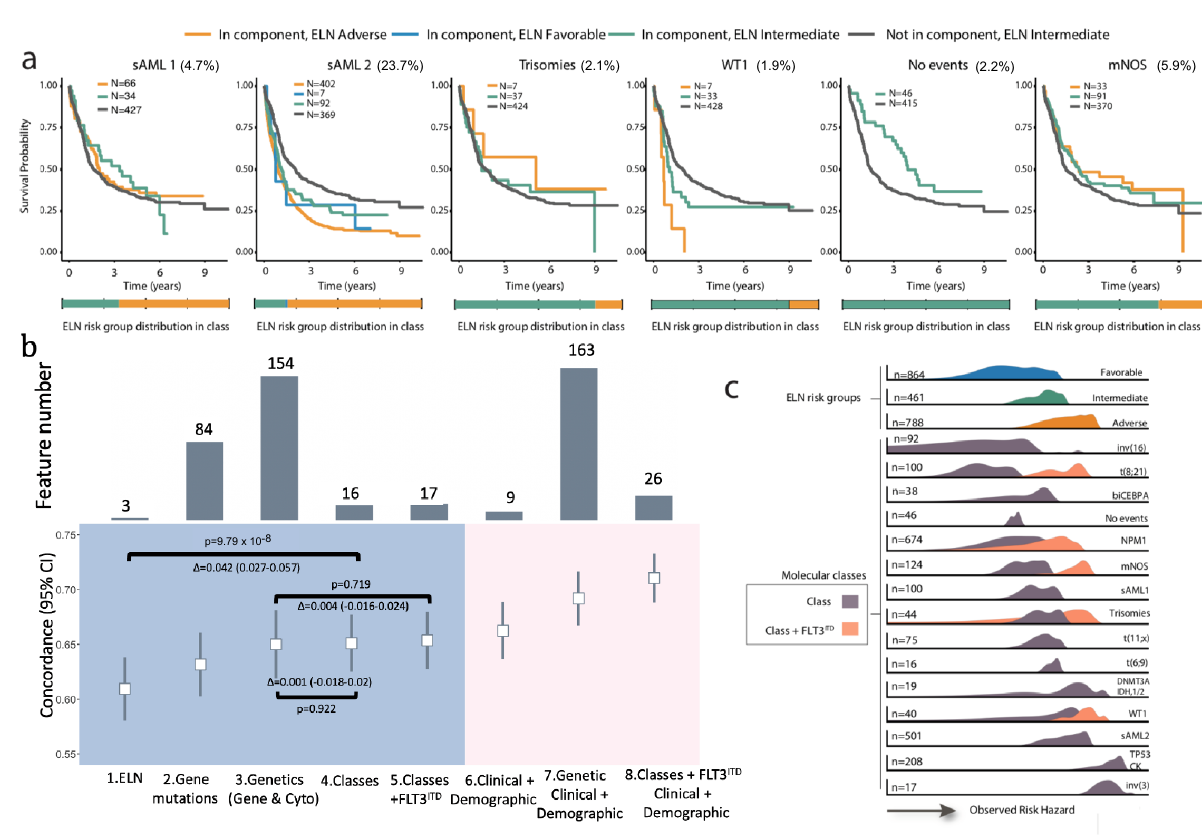
Fig. 2 | Prognostic relevance of molecular subgroups. a Kaplan – Meier overall survival curves for the sAML1, sAML2, trisomies, WT1, no event and mNOS sub- groups, separated by ELN 2017 scores. A bar plot representing ELN 2017 repartition for each class isincluded in the lower panel. b Estimates of the concordance index (C- index) derived from Cox regression with a ridge penalty that consider (1) ELN 2017 strata,(2)gene mutations, (3)molecular classes,(4) molecularclasses+ FLT3 ITD , (5) genetic data (gene mutations and cytogenetics), (6) clinical and demographic, (7) genetic,clinicalanddemographicand(8)classes, FLT3 ITD ,clinicalanddemographic features using internal 5 fold cross-validation for penalty selection. Top panel includes barplots representing the number of features/categories considered in